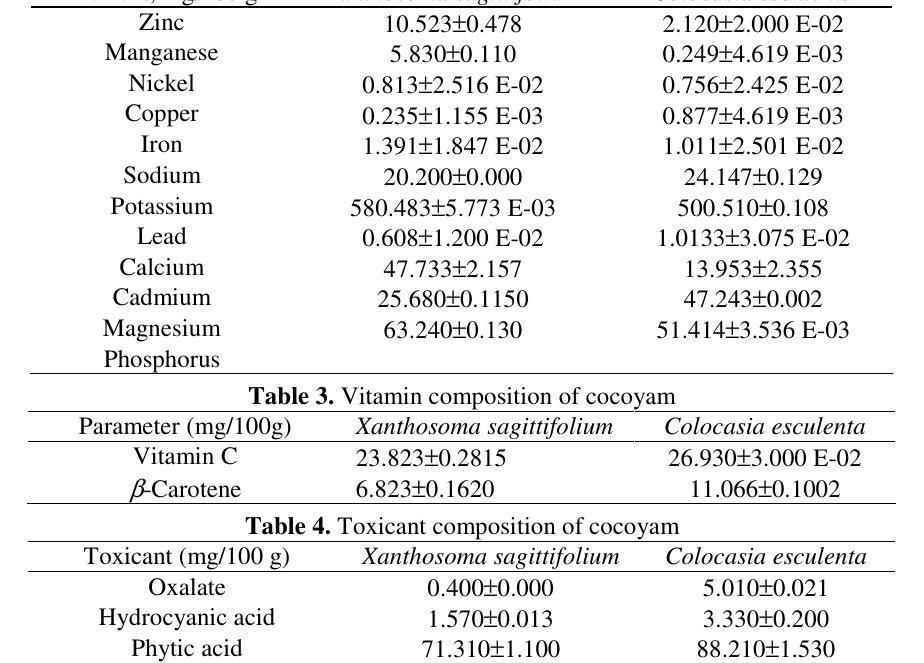
Table 2. Mineral element composition of cocoyam